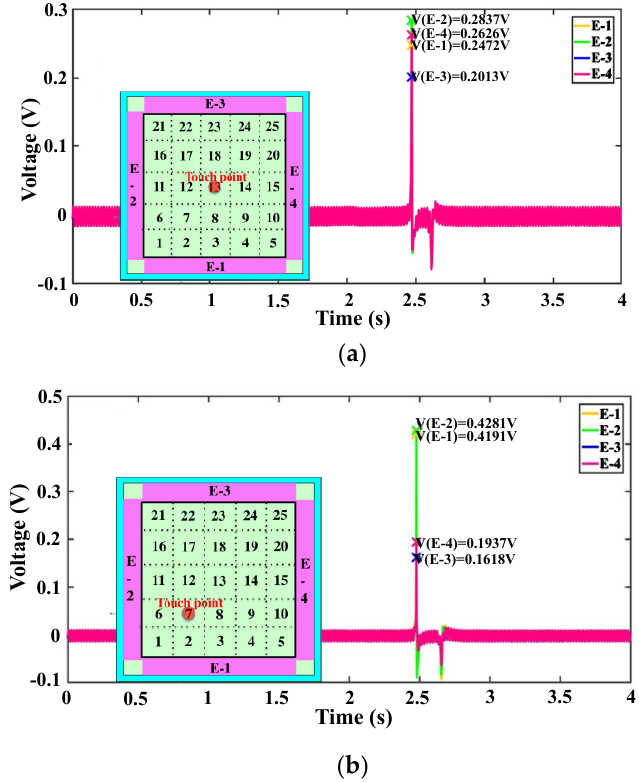
Figure 4. Output voltages of the four electrodes when testing is performed at ( a ) point No. 13 and ( b ) point No. 7.